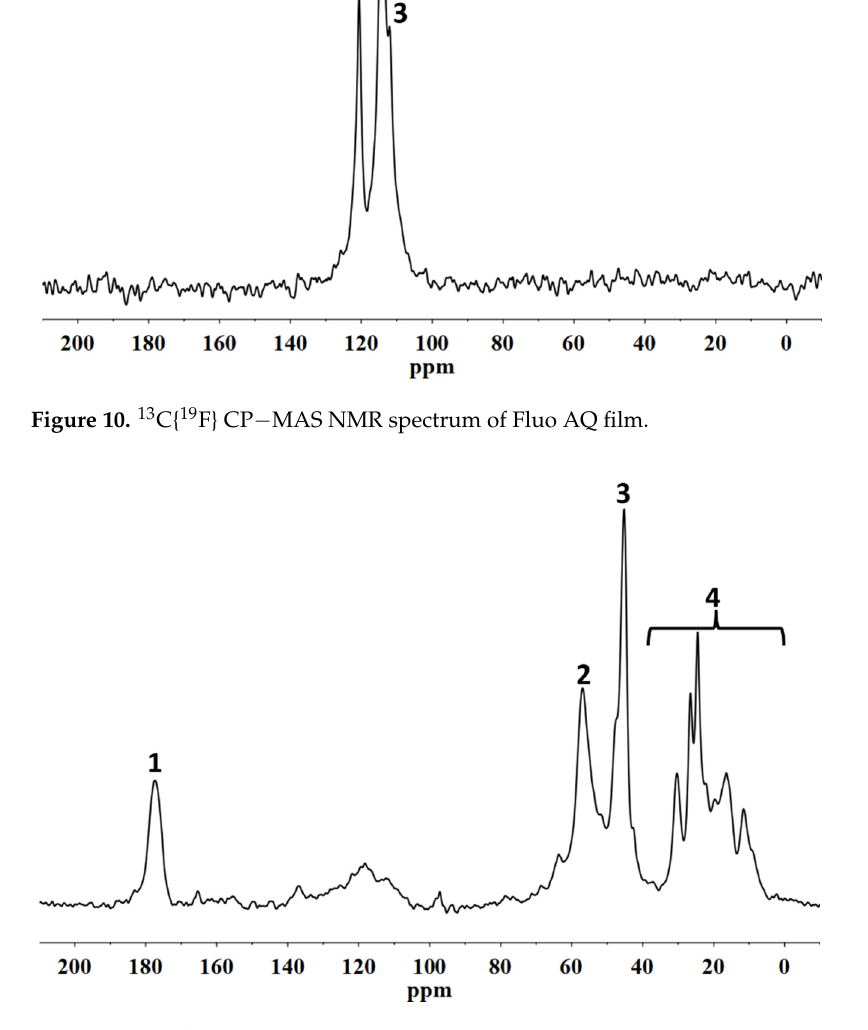
Figure 11. 13 C{ 1 H} CP − MAS NMR spectrum of Fluo AQ film. Table 6. Assignment of the chemical shift of 13 C{ 1 H} CP-MAS spectrum. Table 4. Assignment of the chemical shift 19 F MAS NMR spectrum.